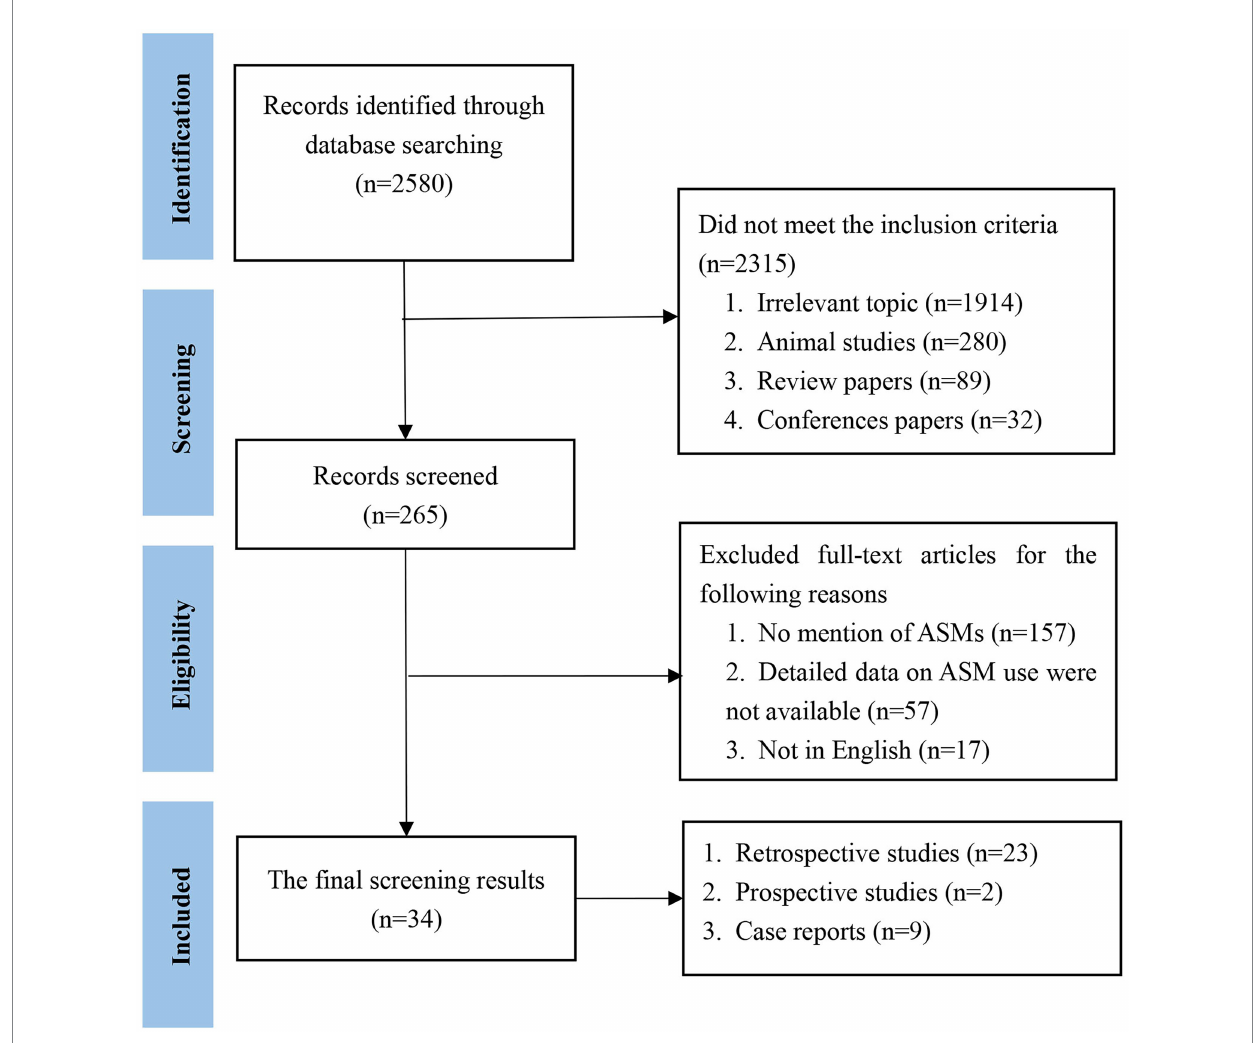
FIGURE 1 Literature search flow diagram.